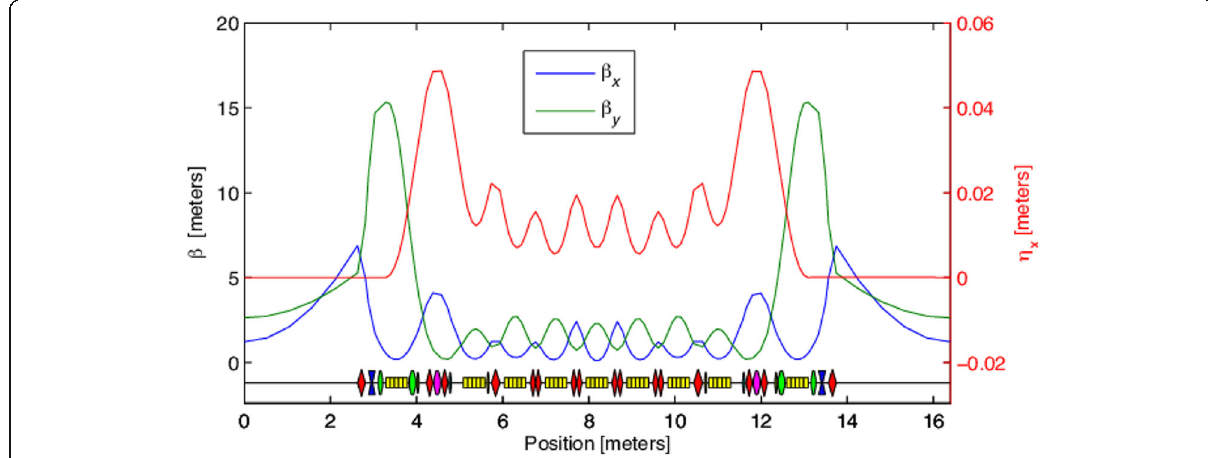
Fig. 6 Multi-bend achromat lattice for ALS-U